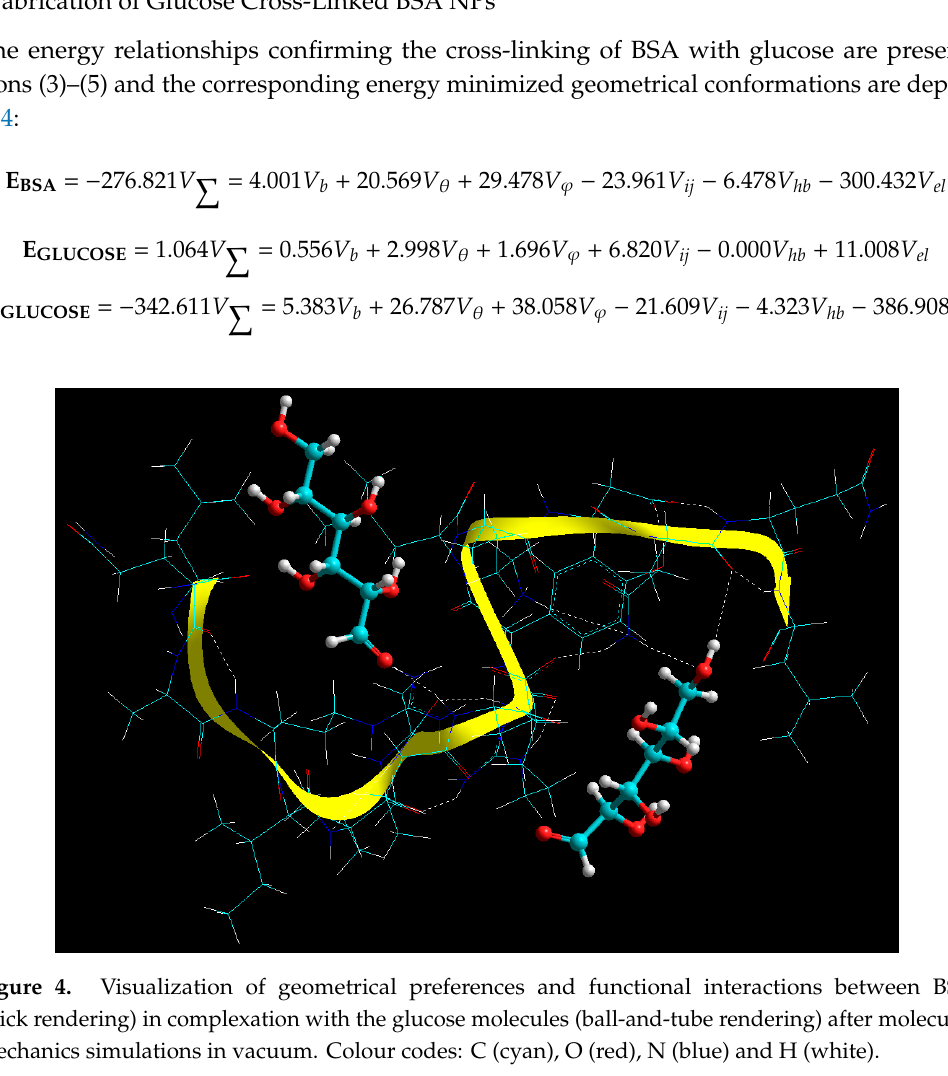
free amine group of BSA (–C = O . . . NH–) [38]; (2) –OH . . . O = C– hydrogen bonding; and (3) -OH . .